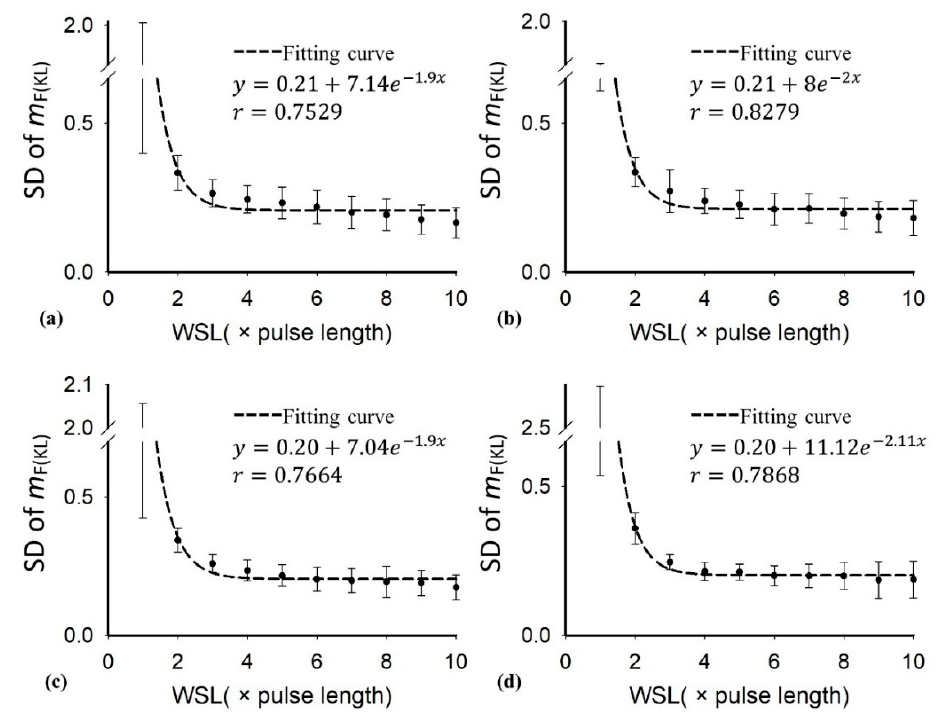
Figure 5. The average and standard deviation (SD) of the parameter m F(KL) in the ROI as a function of the WSL obtained with different grades of hepatic steatosis: ( a ) normal; ( b ) mild; ( c ) moderate; ( d ) severe. By increasing the WSL, the SD of the parameter m F(KL) gradually decreased, and the fitting curve plateaued when the WSL was larger than 5 PL.